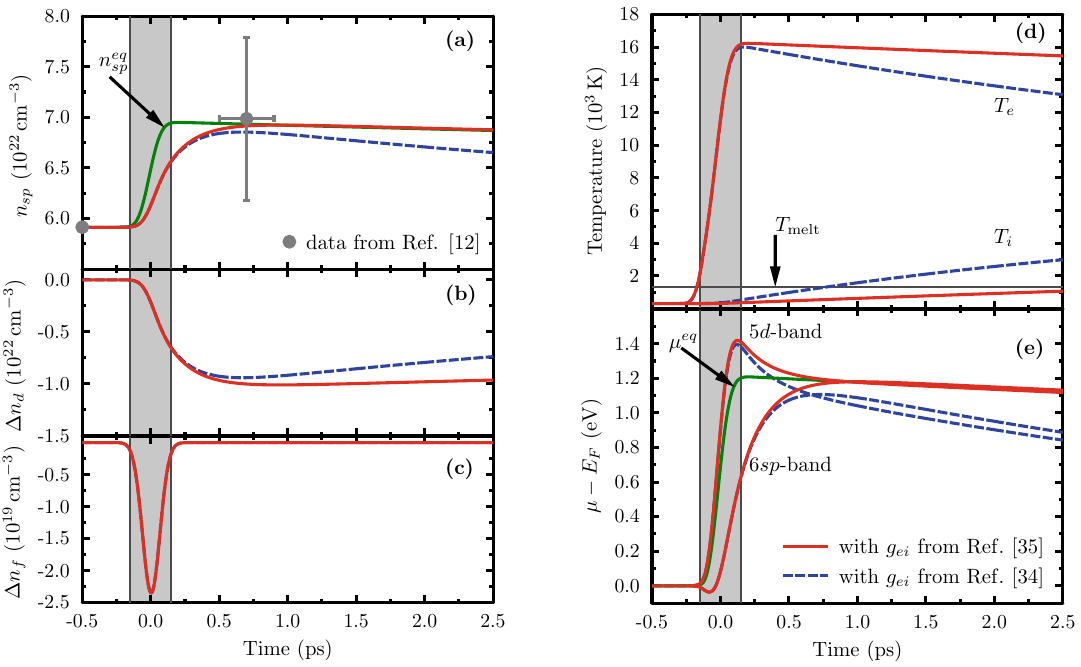
Figure 1. Electron response to XUV excitation of gold: ( a ) evolution of the 6 sp -band density; ( b ) response of the 5 d -band density; ( c ) direct excitation of the 4 f -shell; ( d ) evolution of the electron and ion temperatures; ( e ) the transient chemical potentials relative to the Fermi energy E F for the 6 sp - and 5 d -electrons. The grey shaded area represents the time when the pump pulse is active. The full red lines and the blue dashed lines follow from calculations with the electron–phonon coupling according to Ref. 34 and Ref. 35 , respectively. The green line assumes instant equilibration of the 5 d - and 6 sp -bands. The experimental data point in panel ( a ) is taken from Ref. 12